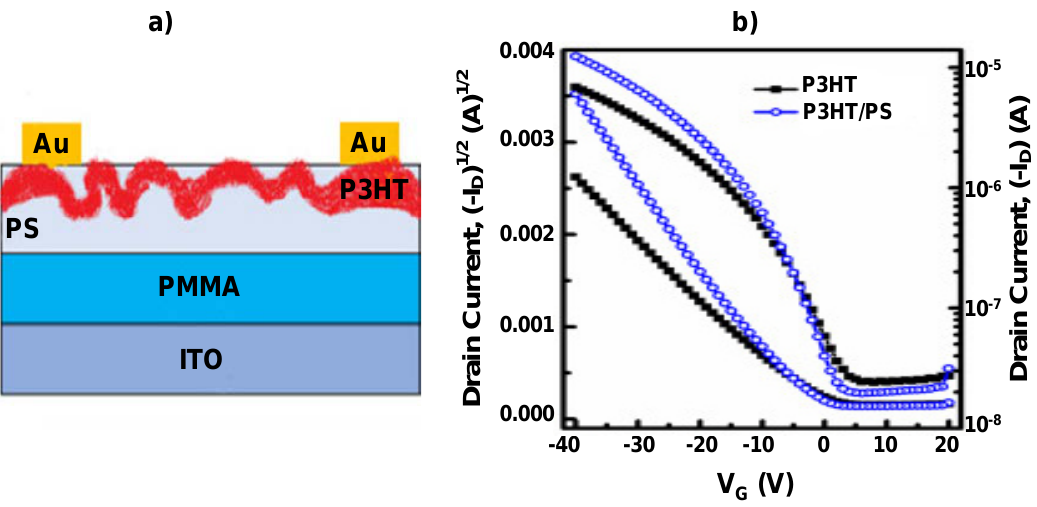
Figure 2. ( a ) Schematic structure of OFET sensor with poly(3-hexylthiophene)/polystyrene (P3HT/PS) blended film; and ( b ) transfer curve of P3HT/PS film with the best mixing ratio of 1:4 in weight. Reprinted with permission from Ref. [22]. Copyright (2016) Elsevier.